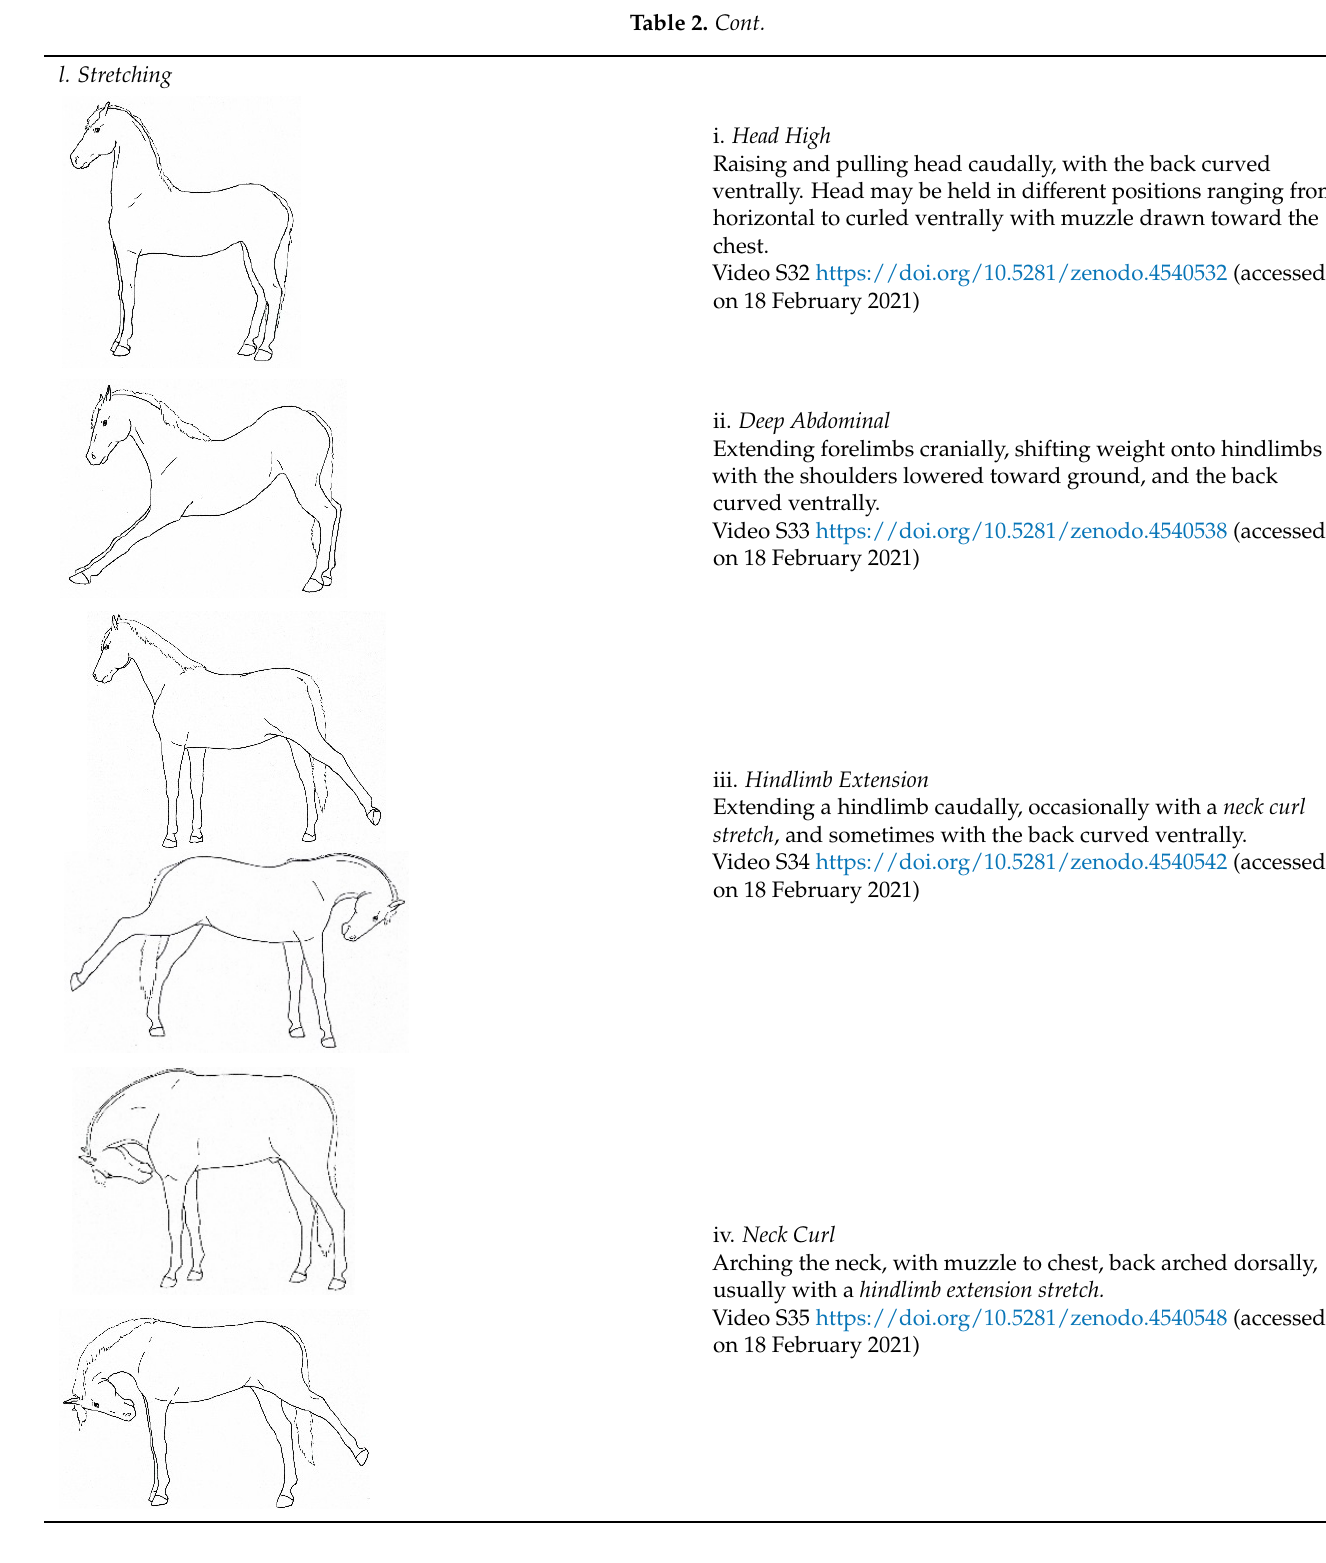
Table 3. Head, neck, mouth, and lip